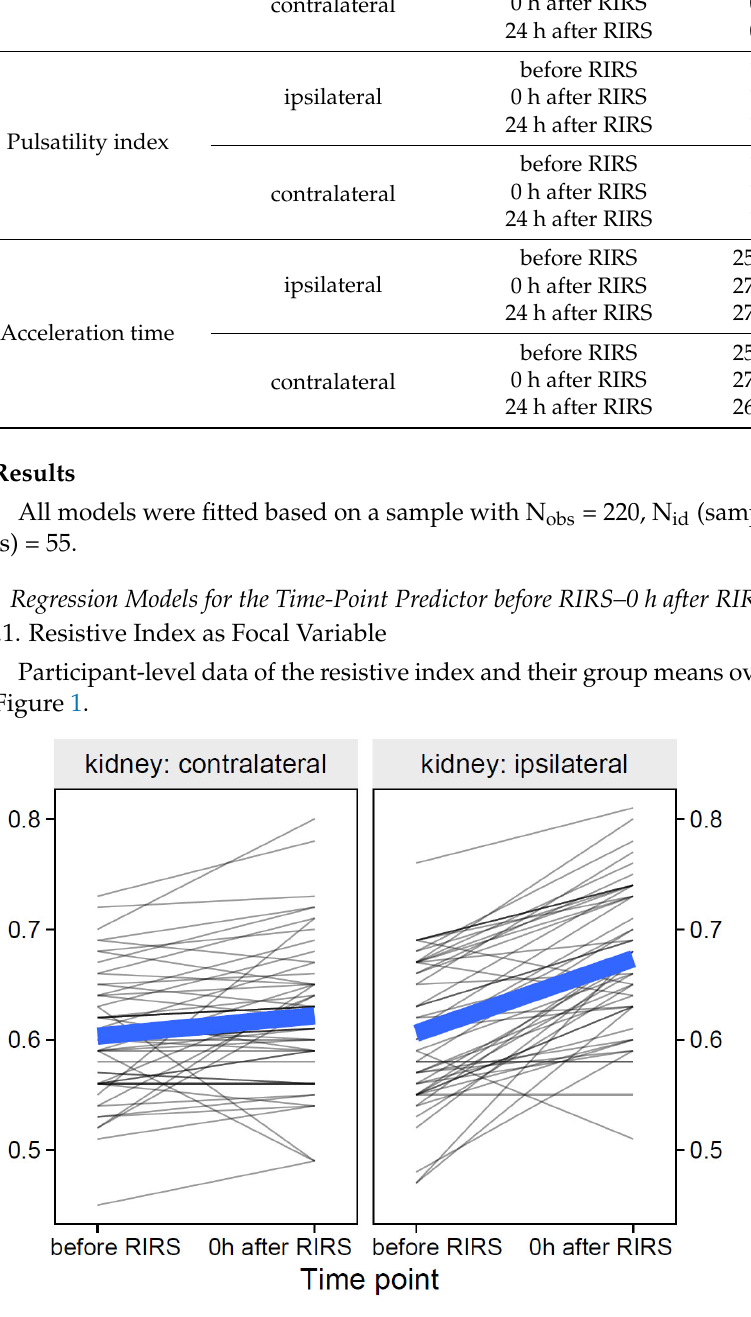
Figure 1. The effect of kidney side on resistive index over time (the thin, semitransparent black lines in the background are the individual-level data. The bold blue lines in the foreground are the group aver- ages). The figure shows that the effects of the kidney side on the focal variable of the resistance index were obviously different over time. The inclusion of the effects of mean stone volume, energy used, pre- stenting, and kidney side at separate time points is presented in Sections